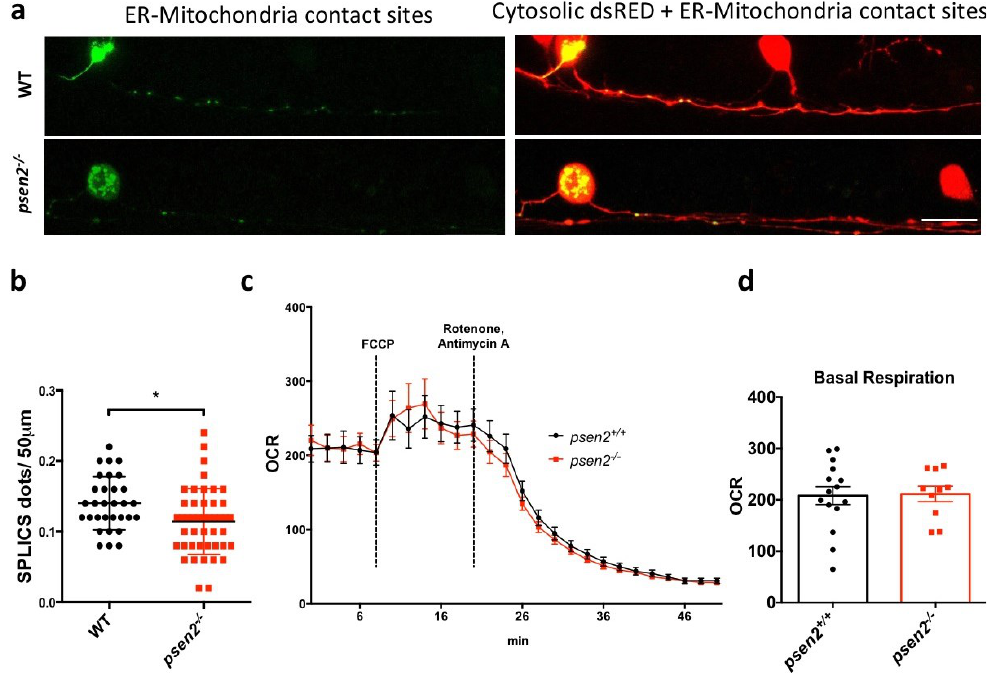
Figure 4. Effects of psen2 genetic manipulation on in vivo ER-mitochondria juxtaposition and mitochondrial respiration. ( a ) Representative images of the transient expression of the SPLICS probe for ER-mitochondria contact sites in RB neurons of 1-dpf WT and mutant embryos. ( b ) Relative quantification of GFP reconstituted dots in the first 50 µm of RB axons in all the conditions analyzed. Data was generated from 3 or more independent experiments/conditions. Statistical significance was determined by two-tailed Student’s t-test. ( c ) Mean oxygen consumption rate (OCR) in psen2 +/+ and psen2 – / – larvae at 4-dpf upon different treatments. Dashed bars indicate the addition of FCCP (0.5 µM) or Rotenone/Antimycin A (2 µM and 5 µM, respectively). Genotyping was performed after OCR measurements. WT: n = 15; psen2 – / – : n = 10. Values represent mean ± SEM. ( d ) Quantification of basal OCR, as reported in (c). Statistical significance was determined by two-tailed Student’s t-test (* = p < 0.05).